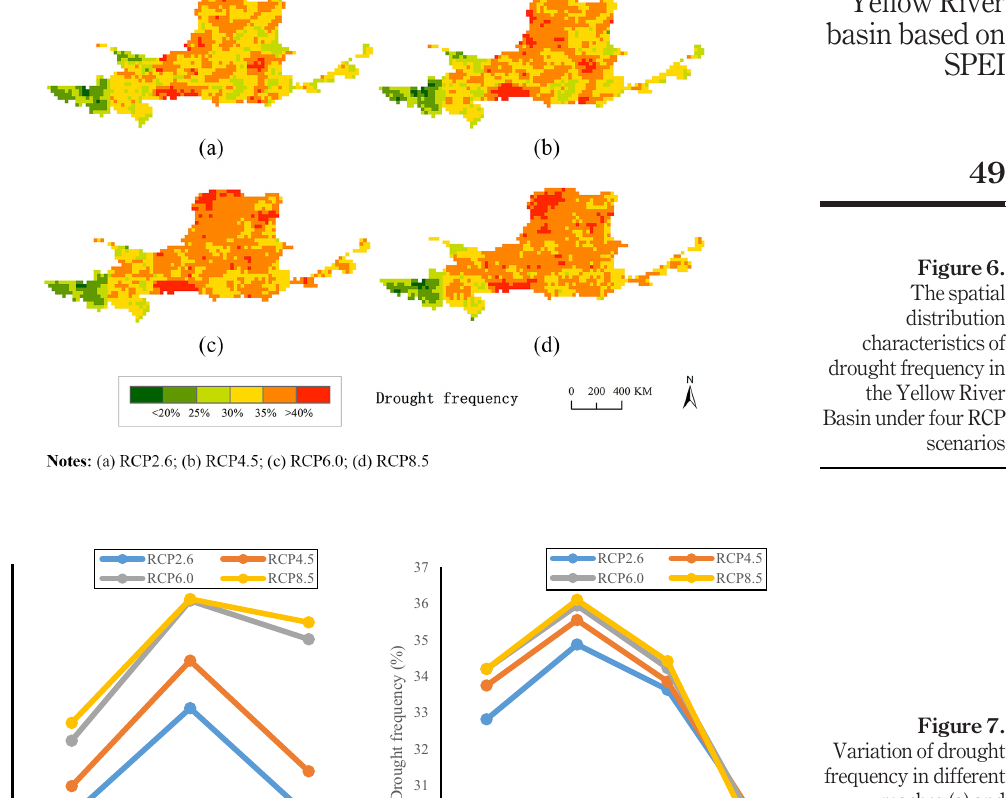
Figure 7. Variation of drought frequency in different reaches (a) and seasons (b) of